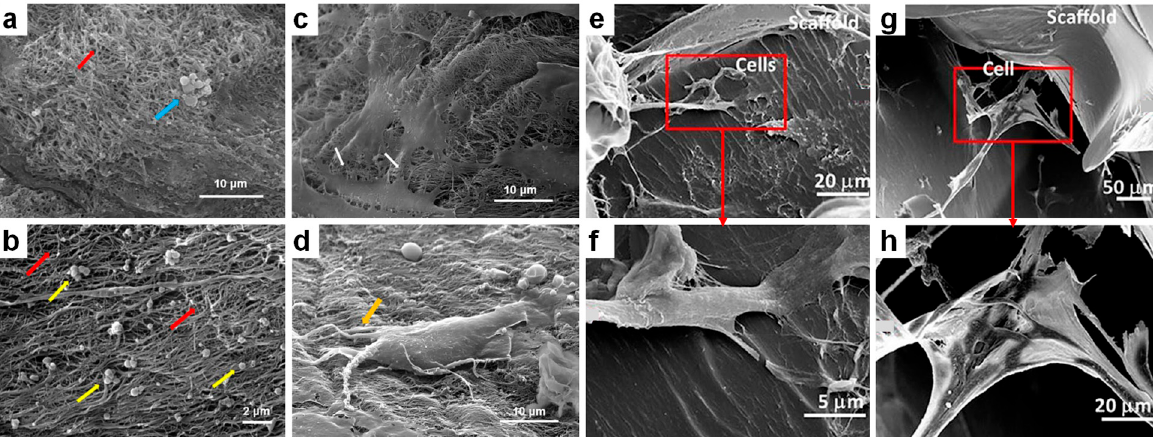
Figure 5. ( a , b ) SEM images of CGF scaffolds depicting 3D fibrin networks comprised of interwoven fibers (red arrows), platelets (yellow arrows) and leukocytes (blue arrow). ( c ) SEM image emphasizing the interaction of DPSCs with CGF (white arrows). ( d ) SEM micrograph showing the cellular filopodia (orange arrow) of fully stretched DPSCs on the scaffold. ( e – h ) SEM images of scaffold-cells structures at two days culture depicting the morphology and adhesion of bone marrow human MSCs in gelatin-based hydrogels containing about 8% ( e , f ) and almost 15% chitosan ( g , h ). Images ( f , h ) represent the zoom-in of rectangular shapes visible in ( e , g ), respectively. Adapted with permission from ref. [127] ( a – d ) and ref. [128] ( e – h ).